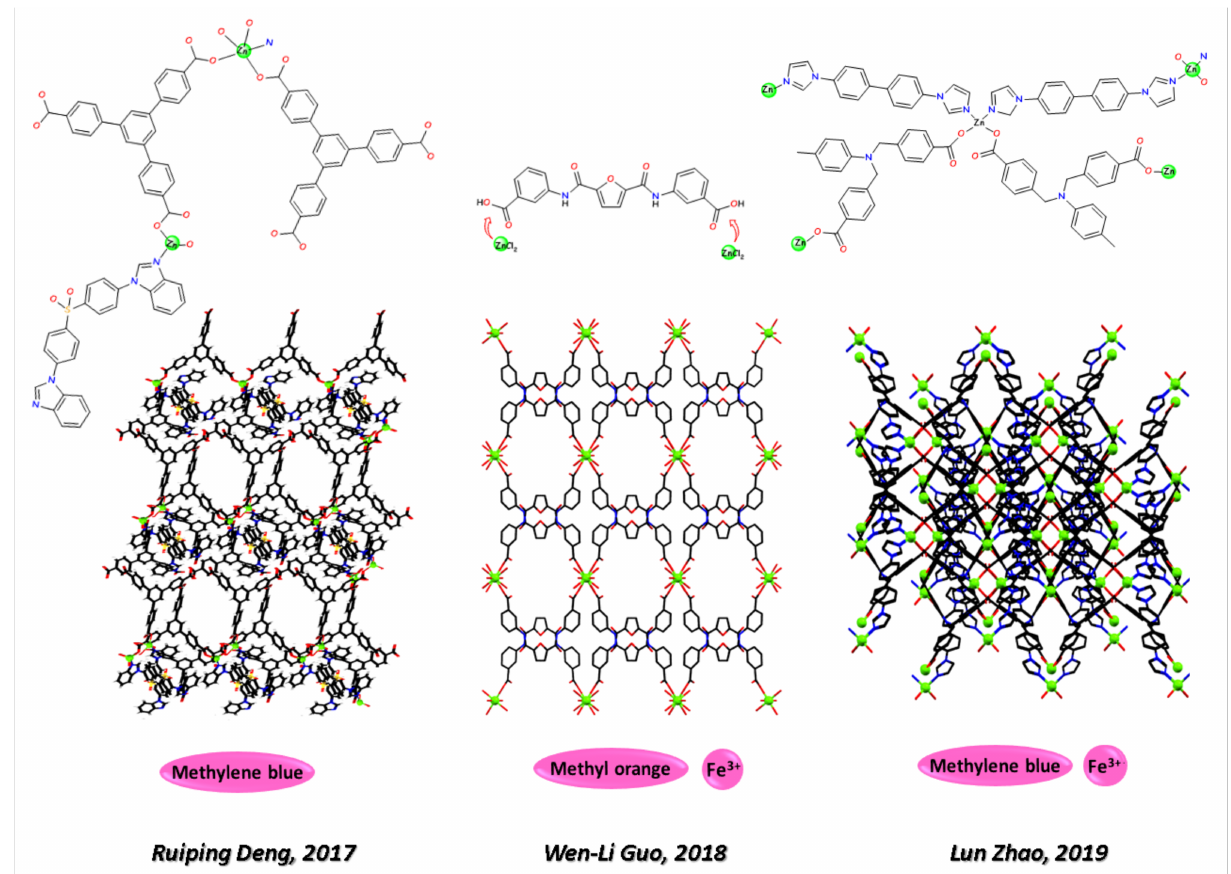
Figure 4. Some representative structures of Zn-CPs for multi-sensing of biologically harmful small organic molecules. Figures readapted by using Mercury software